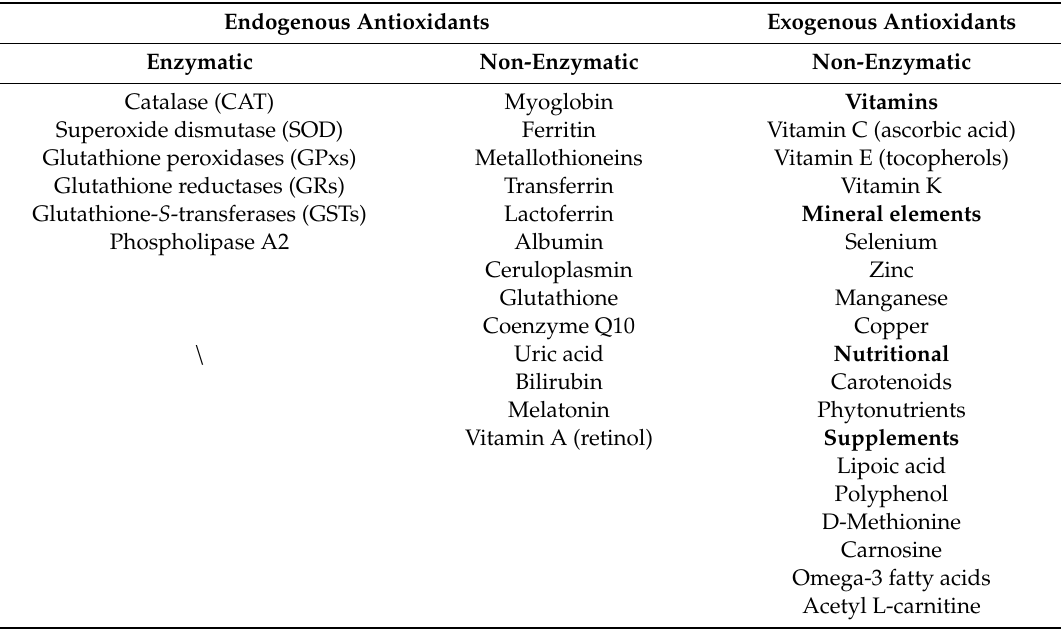
Table 1. Classification of